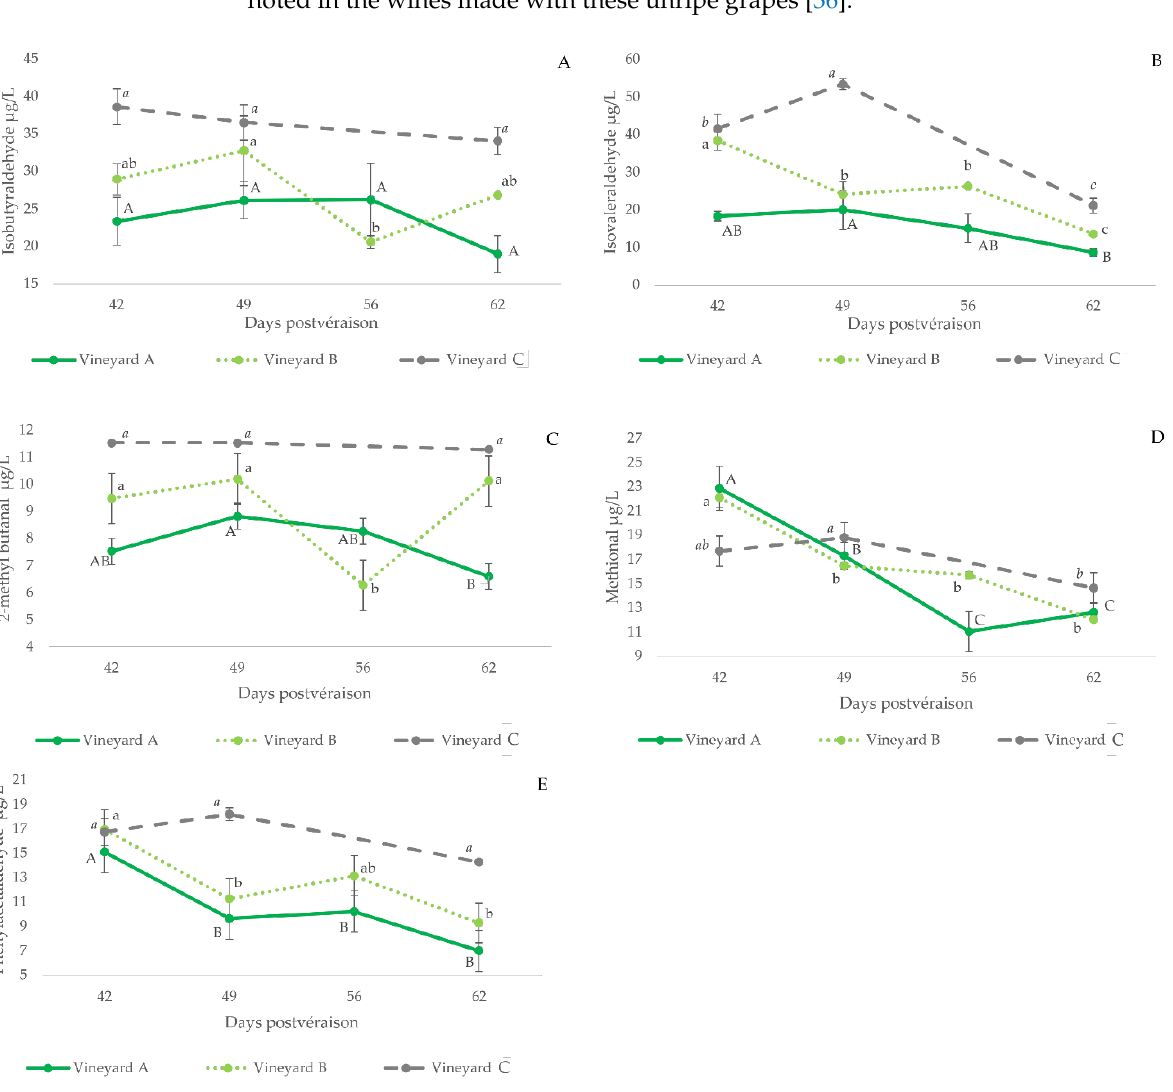
Figure 4. Evolution of the levels of Strecker aldehydes ( µ g/L) measured in wines made with grapes harvested at different degrees of ripeness in the three different studied vineyards. Error bars are calculated as s/( n ) 1/2 (s, standard deviation; n = 3). The letters indicate significant differences in aldehyde content ( p < 0.05) (upper case: vineyard A; lower case: vineyard B; italics: vineyard C). ( A ): isobutyraldehyde; ( B ): isovaleraldehyde, ( C ): 2-methyl butanal; ( D ): methional; ( E ): phenylacetalde- hyde.